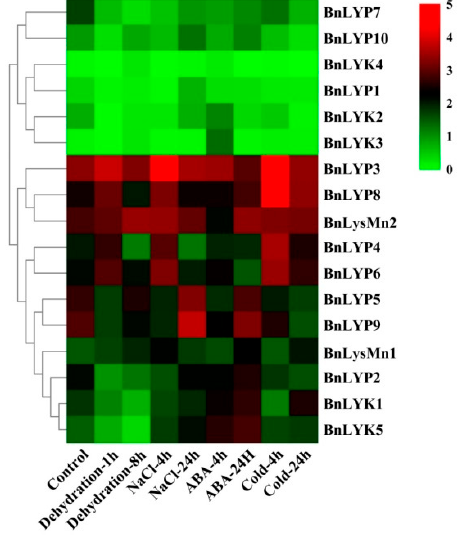
Figure 5. The expression pattern of LysM-RLK genes under abiotic stresses. The color boxes indicate expression values, the lowest (green), medium (black), and the highest (red).